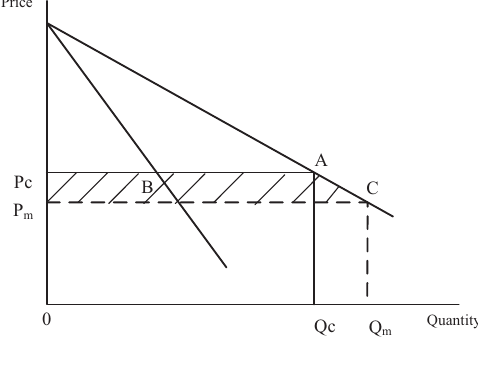
Figure 2. The welfare loss